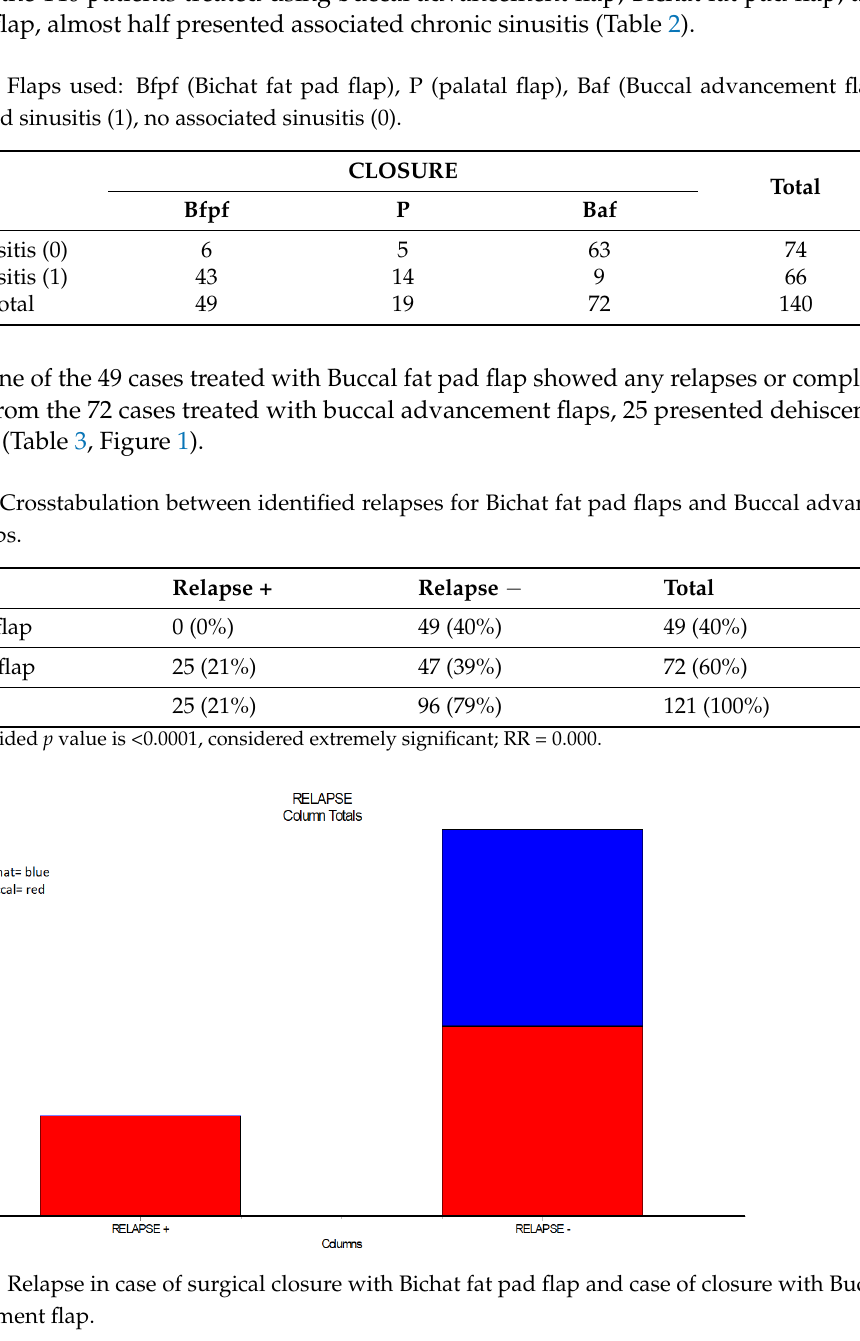
Table 4. Crosstabulation for use of buccal advancement flap in case of defects ranged between 0.3 cm and 0.5 cm and in case of defects ranged between 0.6 cm and 1.5 cm. Relapse +